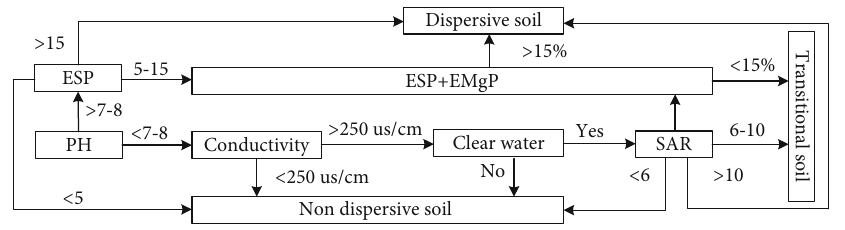
Figure 12: Flow chart of the ESP + EMgP numerical Table 6: Determination results of the ESP + EMgP numerical method (ND: transitional soil; D: dispersive soil).